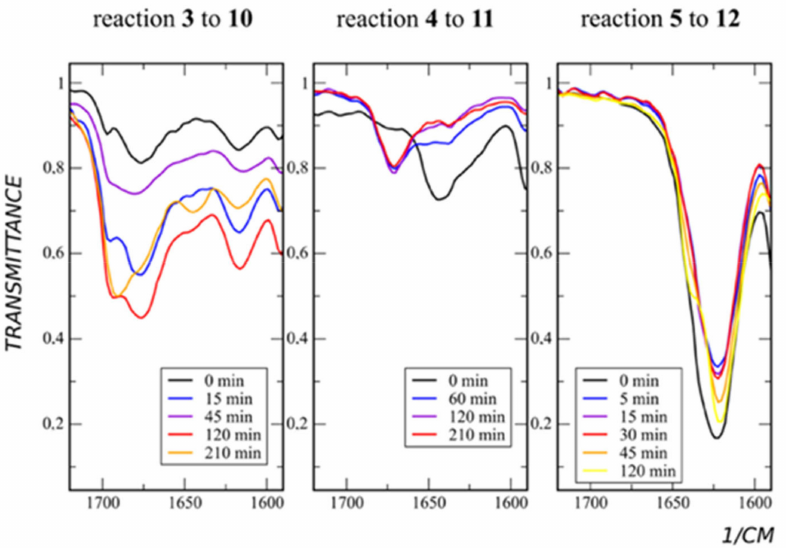
Figure 3. Reaction with sultone. IR spectra of a reaction mixtures taken during the course of the